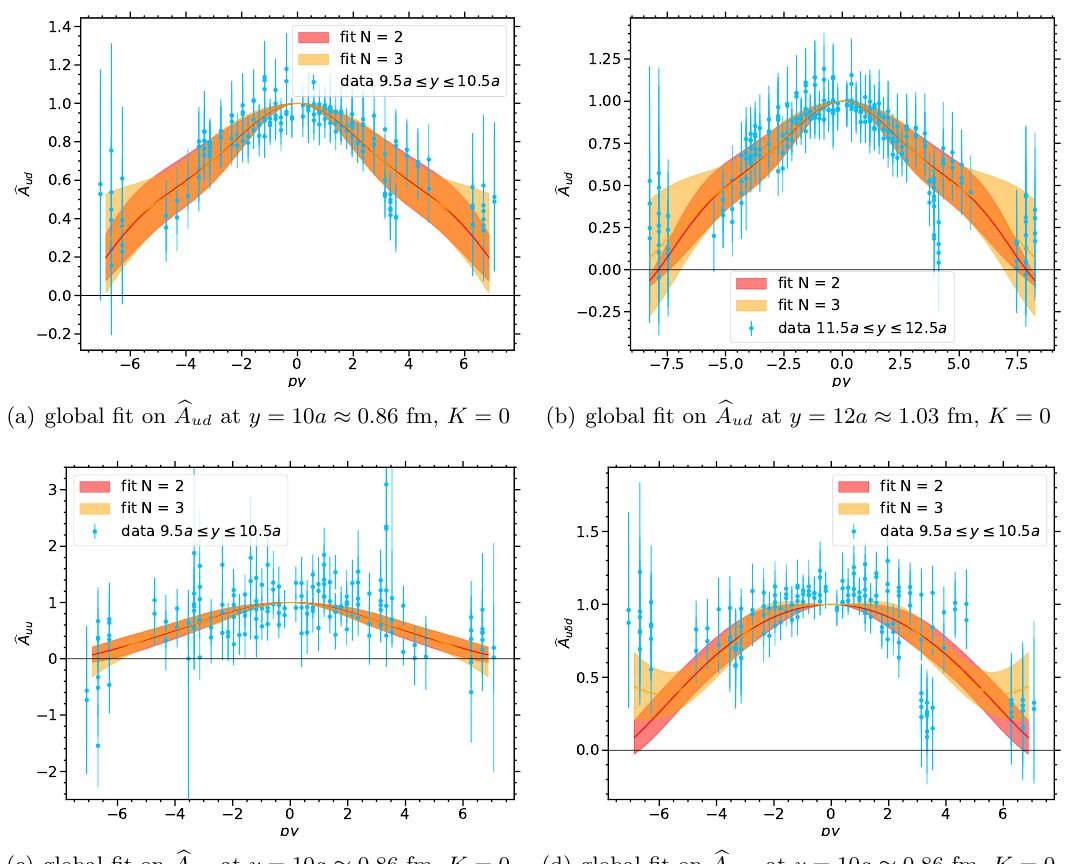
Figure 18 . The same as figure 15 for slices of the global py -fit with K = 0 .